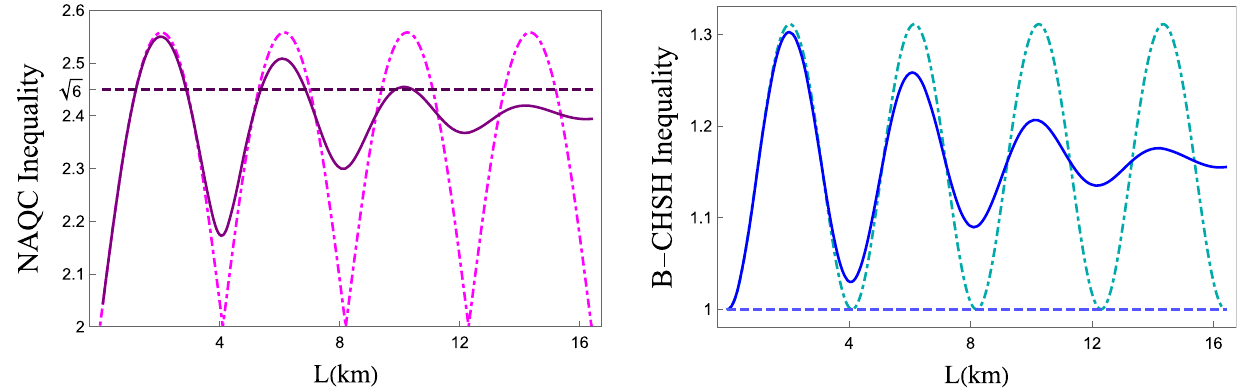
magenta and the lighter blue dashed horizontal lines are the bounds of the NAQC and Bell-CHSH inequalities, respectively. The solid and dot- × 10 − 3 eV 2 and dashed lines represent the plot for the wave packet approach and plane 0 . 11 waves approximation, respectively